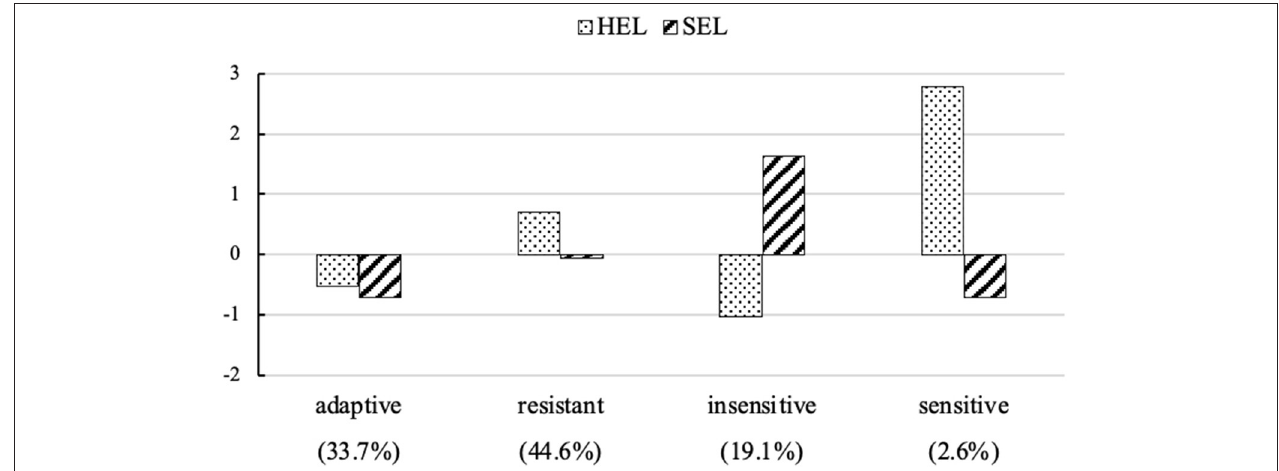
TABLE 3 | The dimensions of perceived stress, resilience, and anxiety for four perceived stress profiles. Adaptive Resistant Insensitive Sensitive F ( p ) Effect size HEL − 0.608 c 0.732 b 1.015 d 2.808 a 2301.299*** 0.766 SEL 0.764 c 0.076 b 1.629 a 0.758 c 1821.654*** 0.721 Resilience 3.371 a 2.721 c 2.946 b 2.942 b 106.232*** 0.131 Anxiety 0.142 c 0.565 b 0.143 c 0.886 a